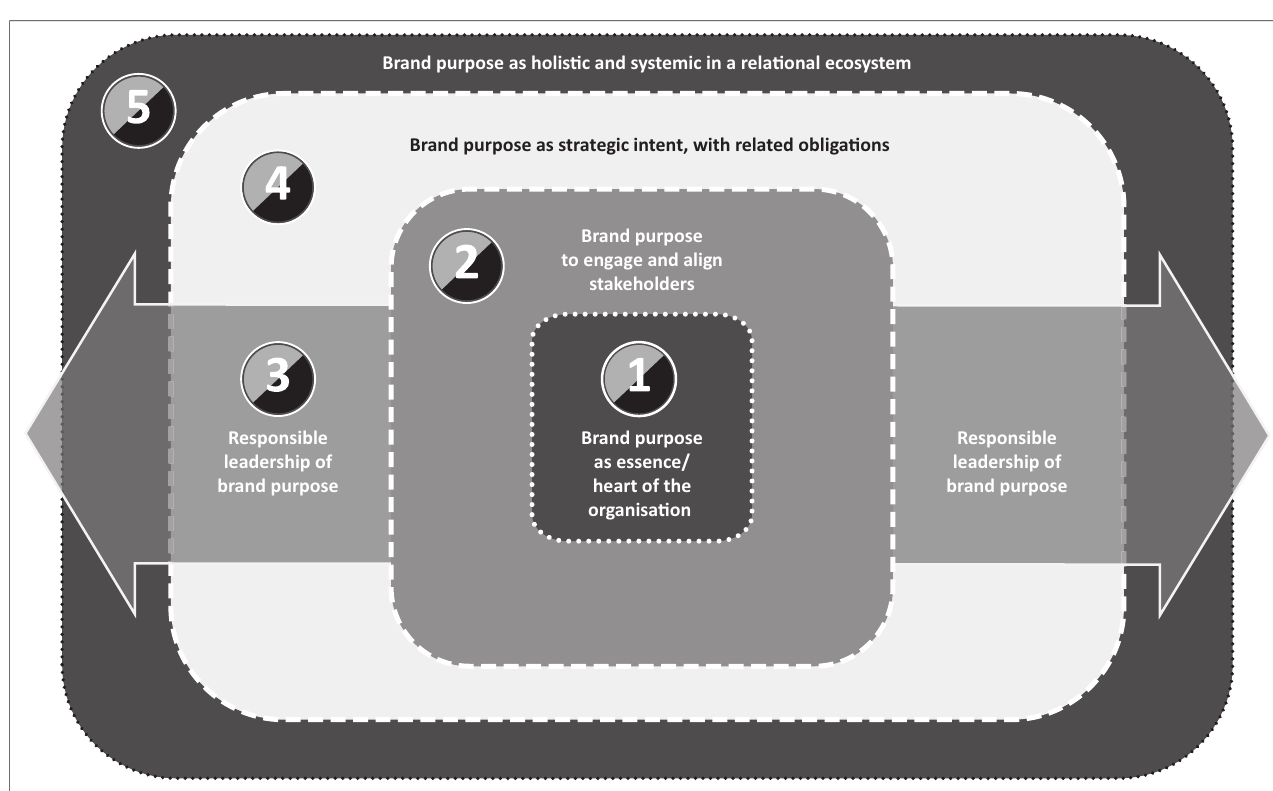
FIGURE 2: Five themes from thematic data